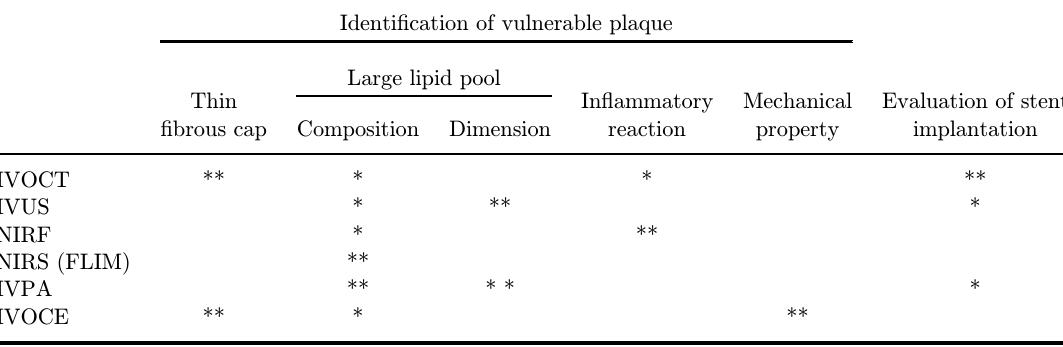
Table 1. Comparison of di®erent intravascular imaging